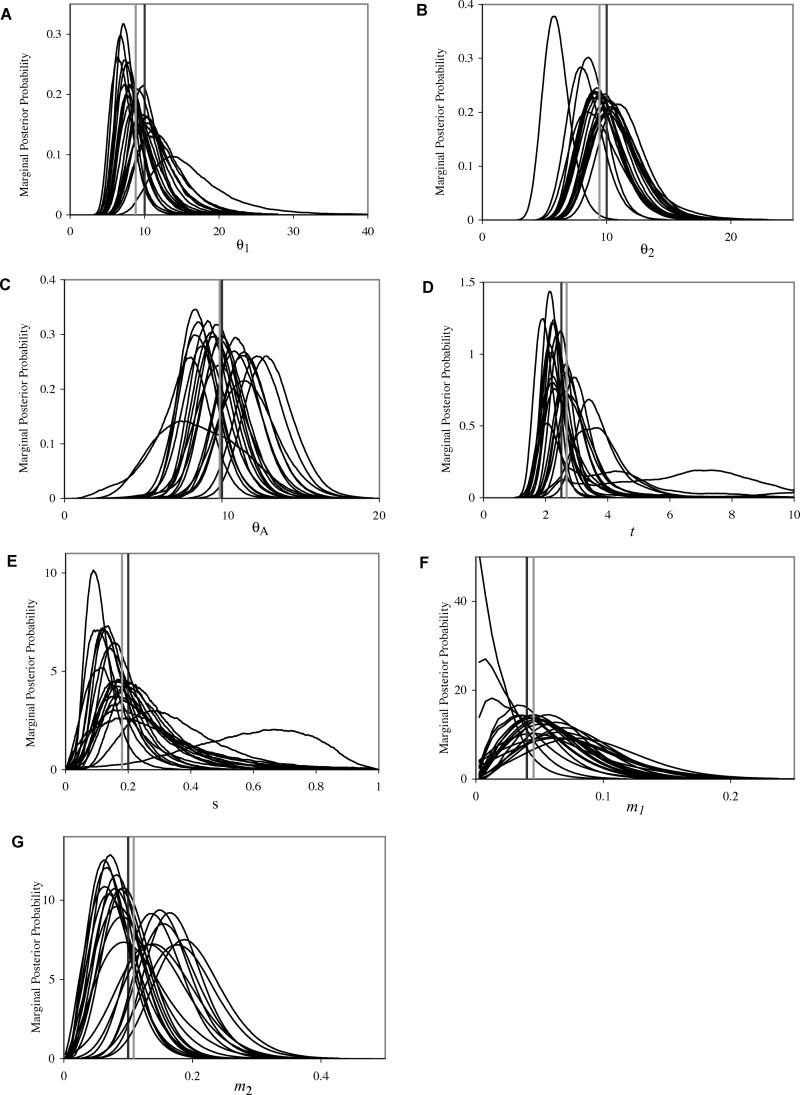
The Marginal Densities Obtained by Fitting the Model with Population Size Change to Simulated DataThe input parameters for the simulations were as follows: (A) θ1 = 10; (B) θ2 = 10; (C) θA = 10; (D) t =2.5, (E) s = 0.2, (F) m
1= 0.04; (G) m
2= 0.2 ; and t = 5 (t/2NA = 0.5). For each simulated dataset, coalescent simulations were done for each of 20 loci with identical mutation rates under an infinite sites mutation model, each with sample sizes of 10 for each of the two populations. Each simulated dataset was analyzed using wide uniform prior distributions for each parameter. Each analysis began with a burn-in period of 300,000 steps followed by a primary chain of 3 million to 10 million steps. The curves for parameters θ1 through m2 are shown in (A) through (G), respectively. For each figure, the true parameter value used in the simulations is shown as a black vertical bar, and the mean of the estimates for the 20 simulations (based on peak locations) is shown as a gray vertical bar.